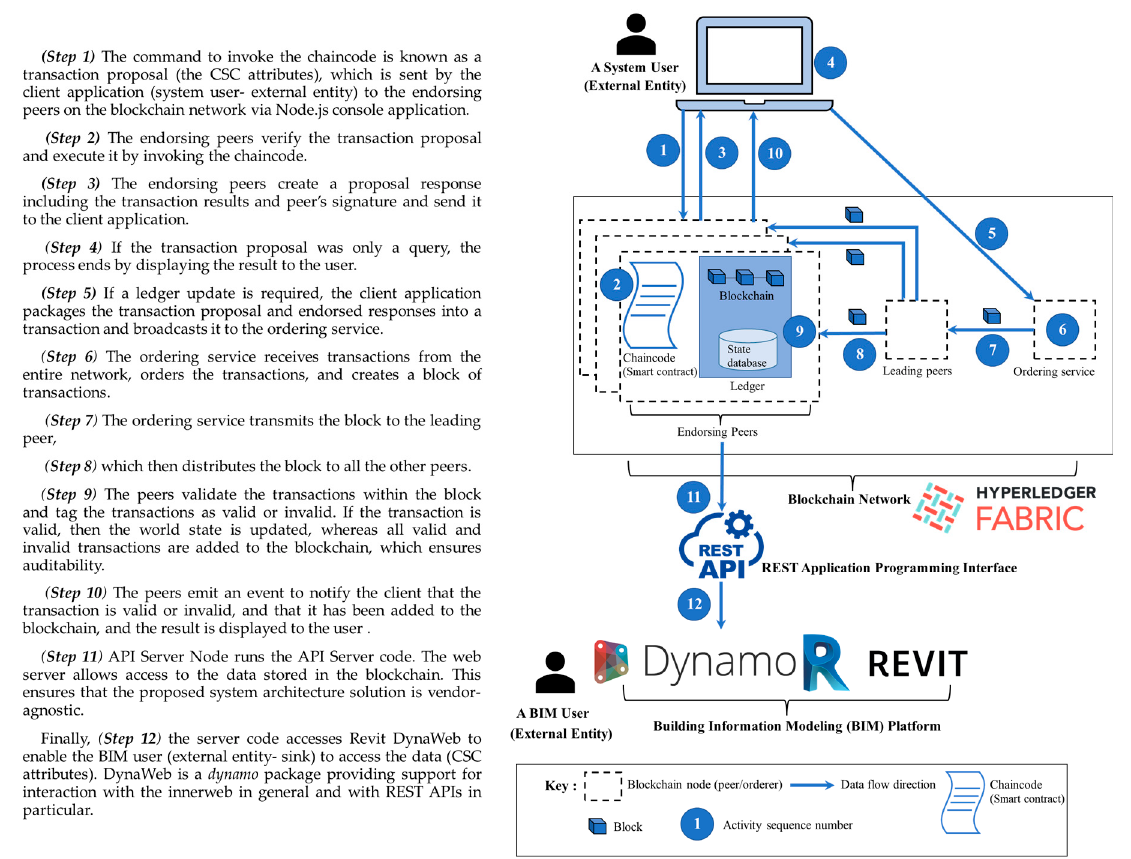
Figure 4. Physical system architecture for integrating BIM with the Hyperledger Fabric platform ( a blockchain technology platform ).